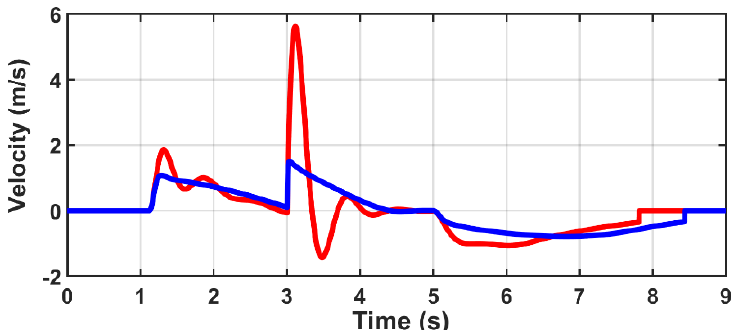
Figure 6. Dynamic response of the PAM manipulator arm velocity for the case without a hydraulic damper (red line) and the case with a hydraulic damper (blue line).